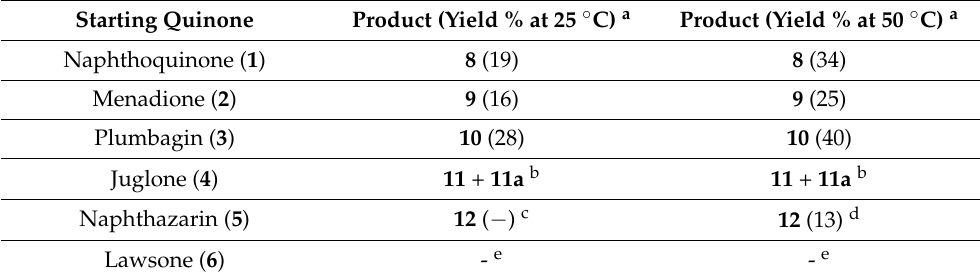
Figure 3. Keto–enol tautomerism in lawsone.